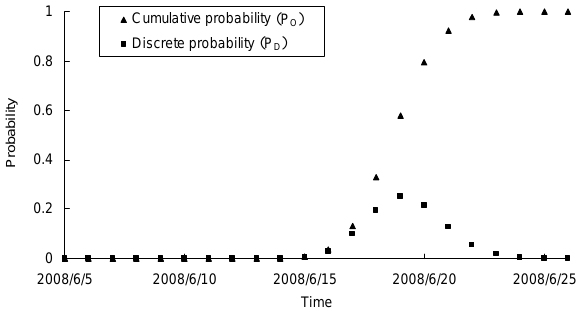
Fig. 6. Predicted lake volume in stage 1 using the time series analysis method.